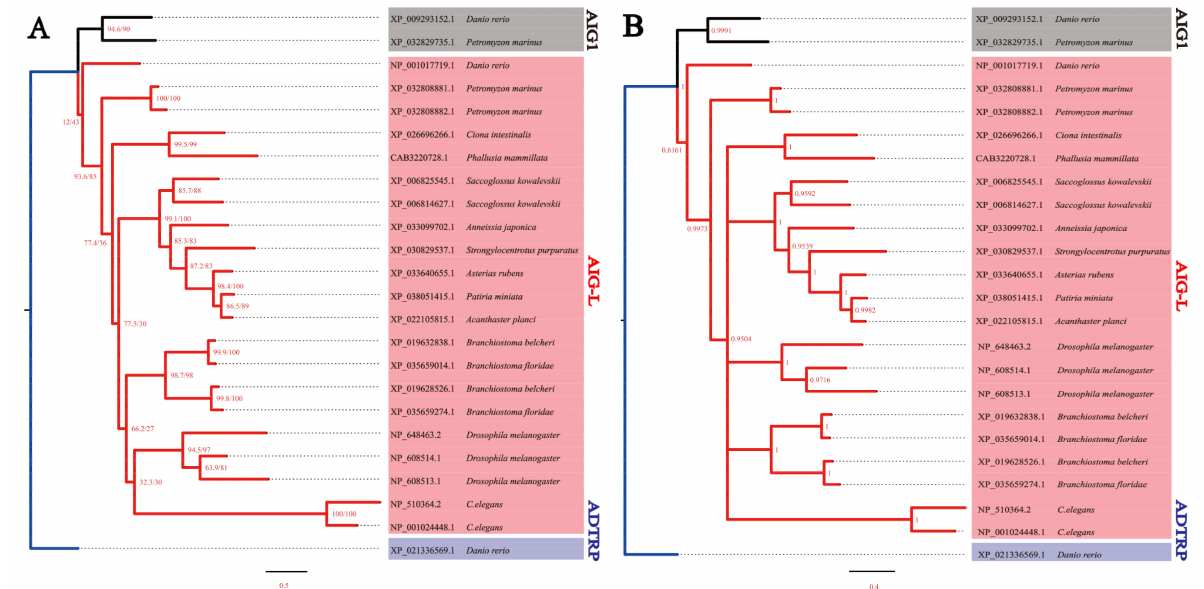
Figure 2. Preliminary phylogenetic classification of invertebrate AIG-Ls using ML ( A ) and Bayesian approaches ( B ). The aLRT/UF-boot values are labeled on each node in A, while the Bayesian posterior probabilities are shown for each node in B. The substitution matrices of mtInv+G4+F and JTT+G4+F were utilized for IQ-tree and MrBayes, respectively. Both trees rooted with zebrafish ADTRP. ADTRP, AIG1, and AIG-L are highlighted in blue, black, and red, respectively. Invertebrate AIG-Ls display a phylum-specific diversification